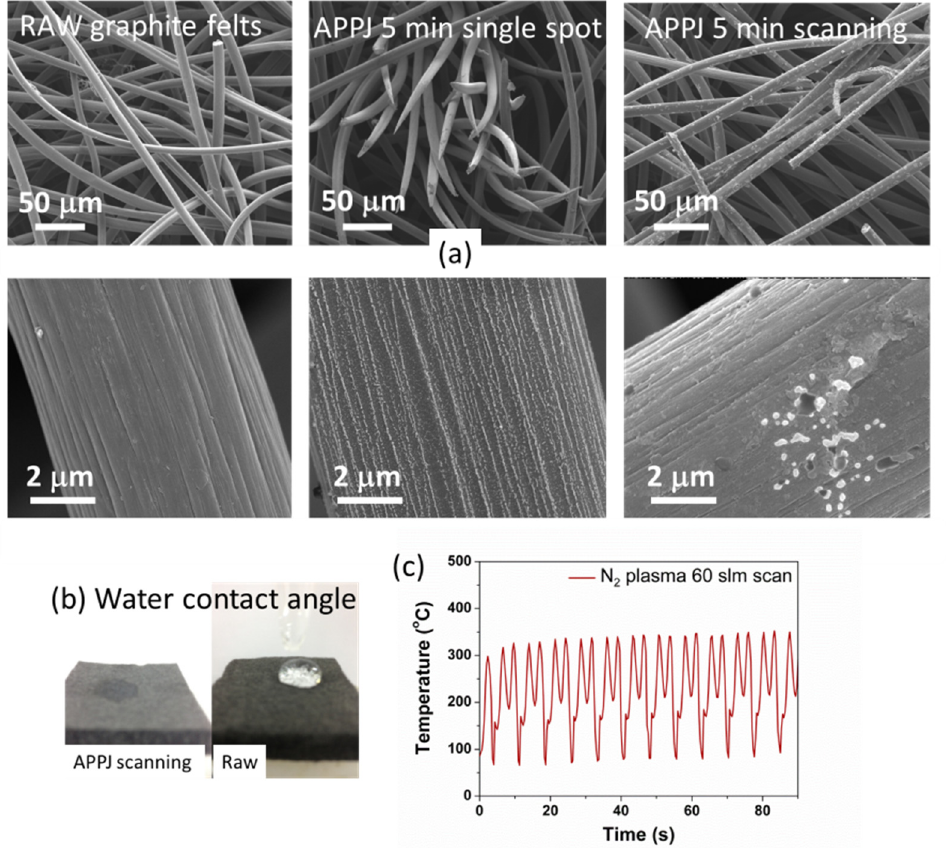
Figure 6. Graphite felts treated by APPJs. ( a ) SEM images; ( b ) water contact angles; and ( c ) substrate temperature evolution under APPJ scanning